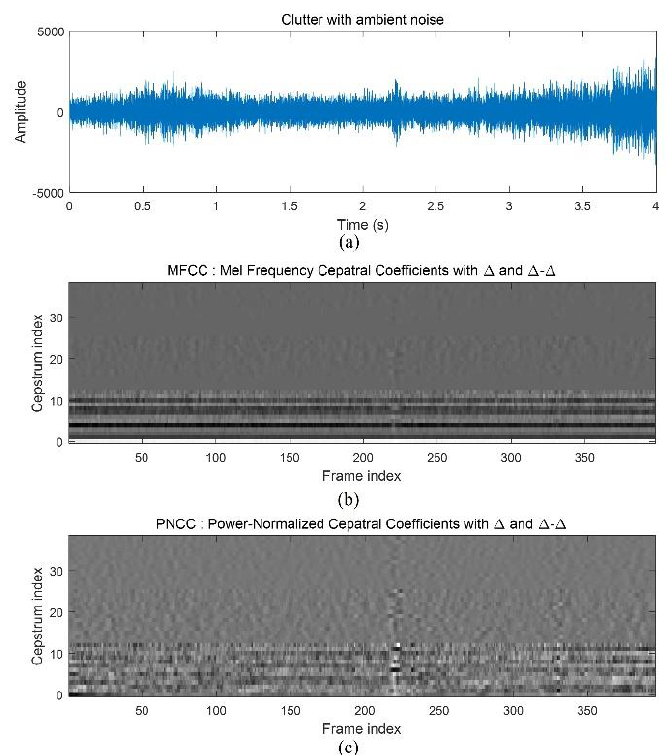
Figure 7. Feature extraction results for clutter: ( a ) time signal of clutter with ambient noise; ( b ) MFCC feature extraction result of clutter; ( c ) PNCC feature extraction result of clutter.